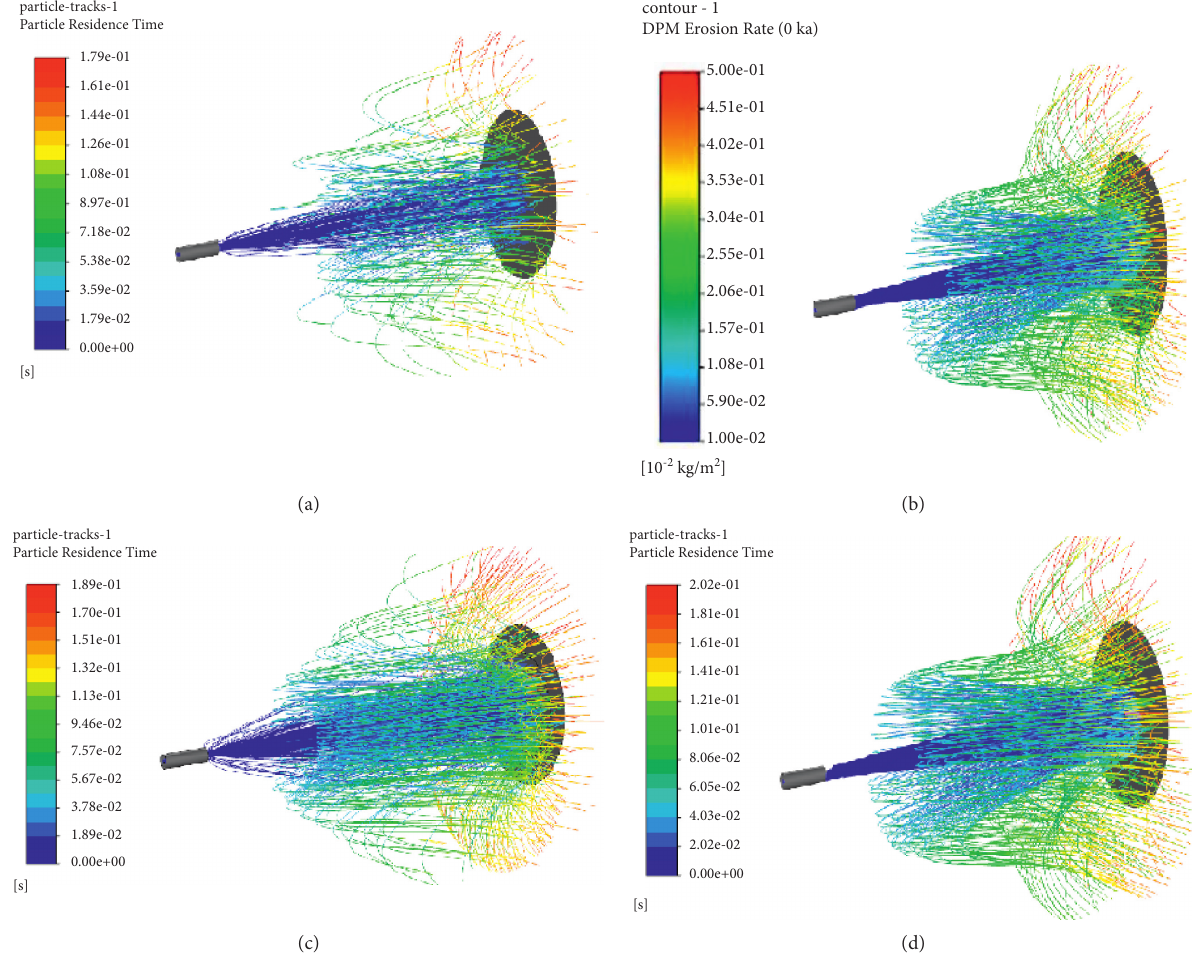
Figure 7: The trajectory results of the abrasive with different blasting pressure. (a) The trajectory of the abrasive with the blasting pressure of 0.5MPa. (b) The trajectory of the abrasive with the blasting pressure of 0.6MPa. (c) The trajectory of the abrasive with the blasting pressure of 0.7MPa. (d) The trajectory of the abrasive with the blasting pressure of